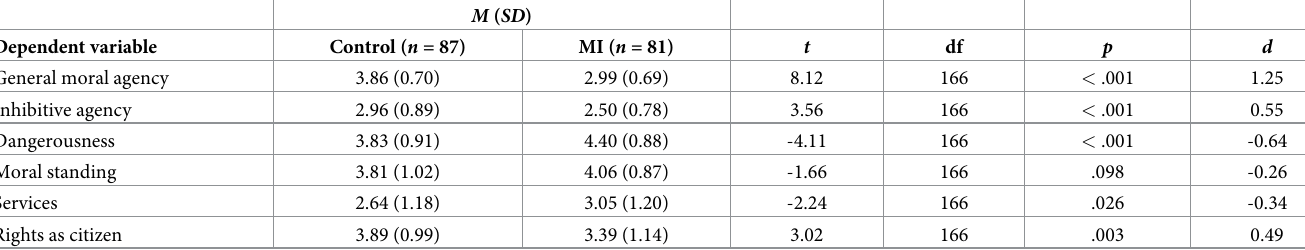
Table 3. Descriptive and t-test statistics for dependent variables after release (Study 1).